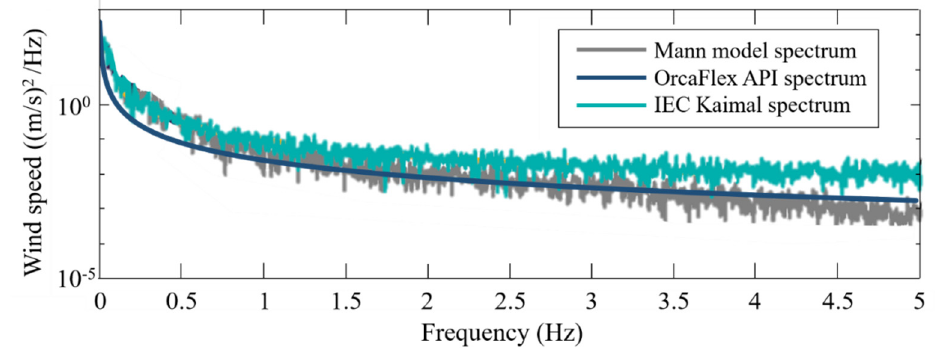
Figure 5. Comparison of different types of input wind spectrum.